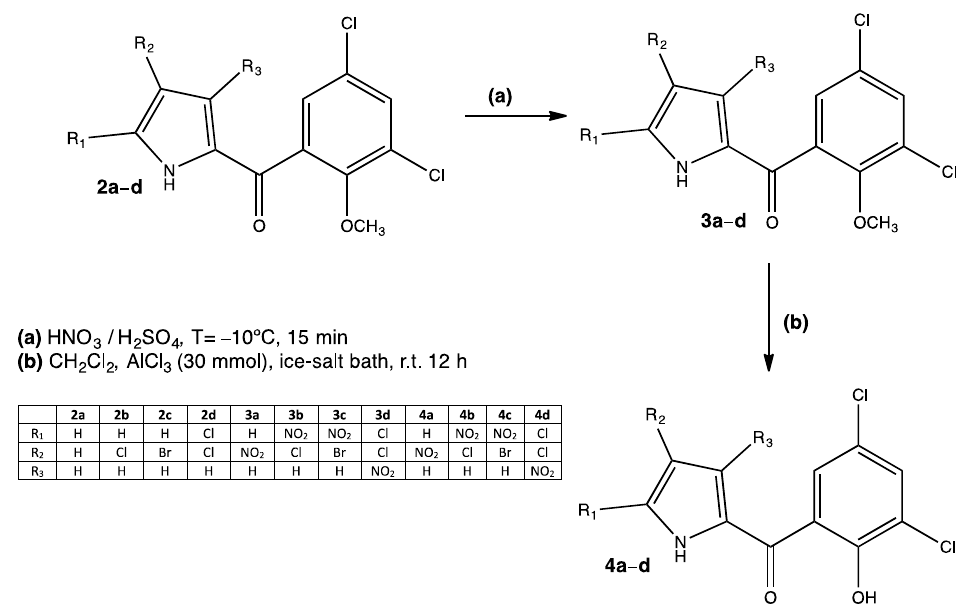
Figure 3. Nitrated pyrrolomycins with potential antibacterial activity [24].